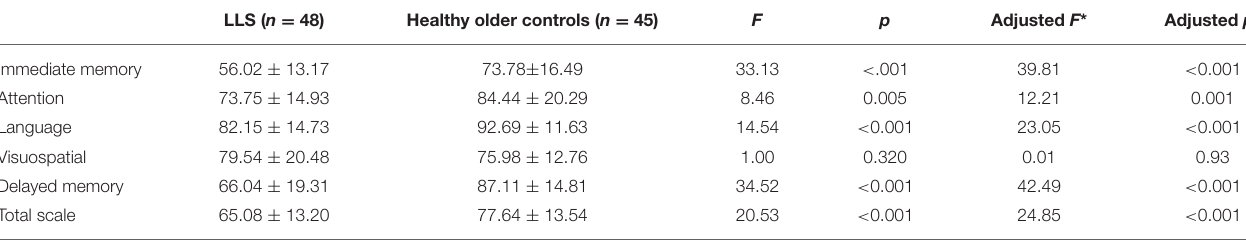
TABLE 2 | Total and each index scores on the RBANS in late-life schizophrenia (LLS) vs. healthy older controls.